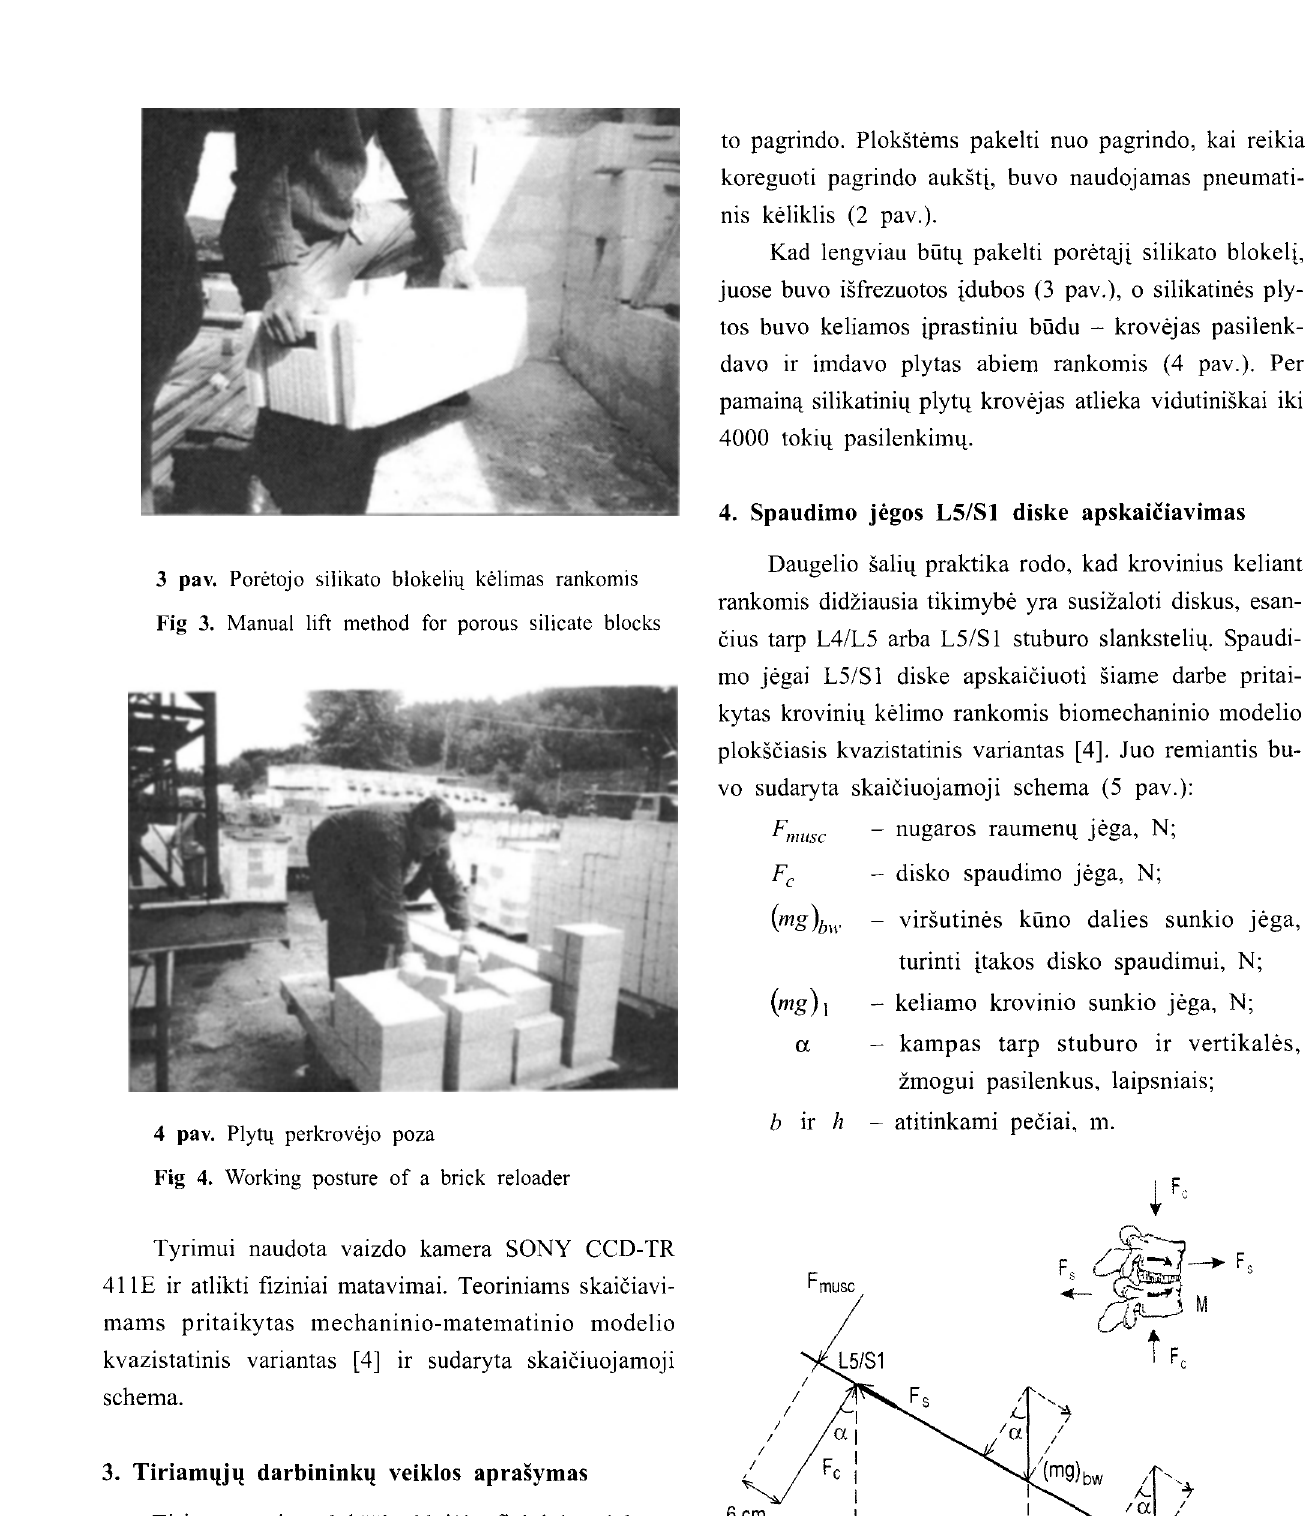
4 pav. Plytl.l perkrovejo poza Fig 4. Working posture of a brick reloader